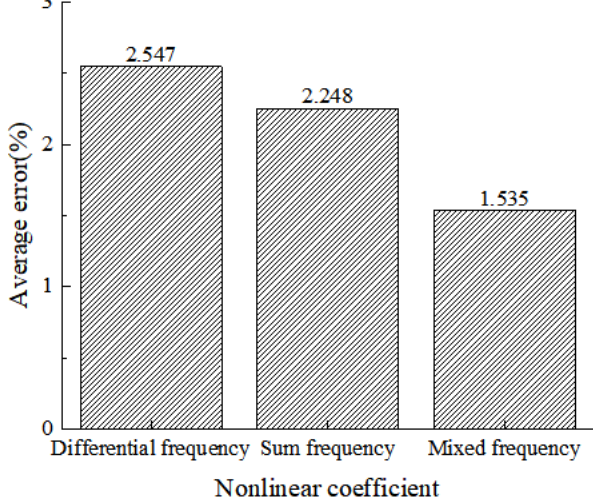
Figure 24. Prediction of crack depth by the nonlinear coefficient.